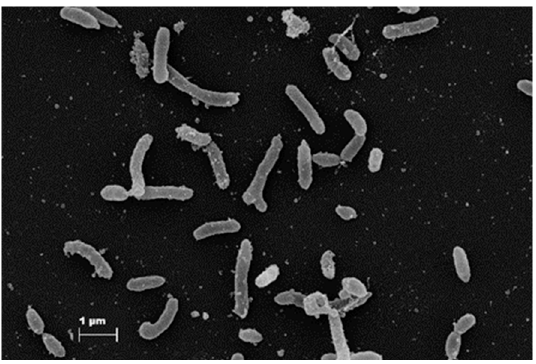
Figure 1. Scanning electron microscopy image of strain WHA3 T .